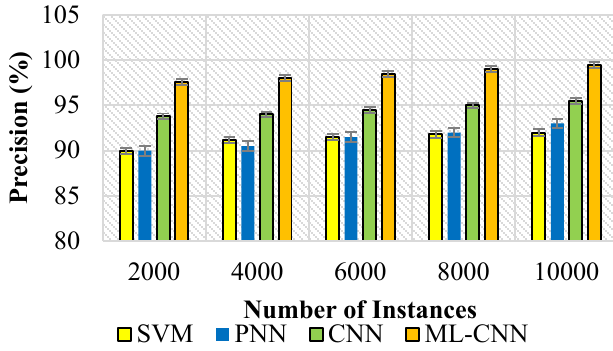
Figure 10. Precision vs. number of instances.